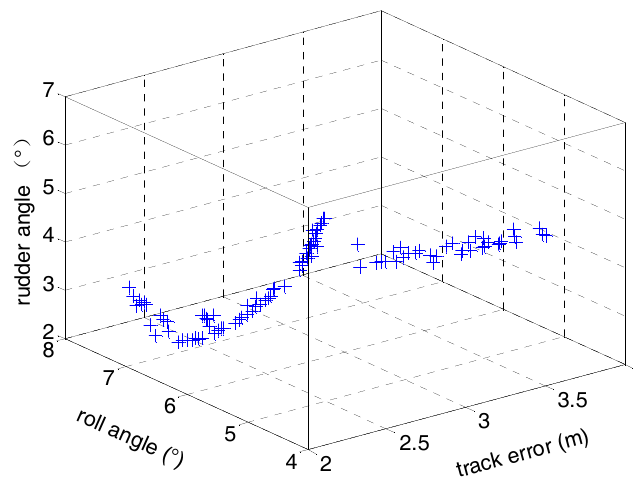
Figure 6. The Pareto optimal sets distribution for PFA-RRR based on NSGA-II.